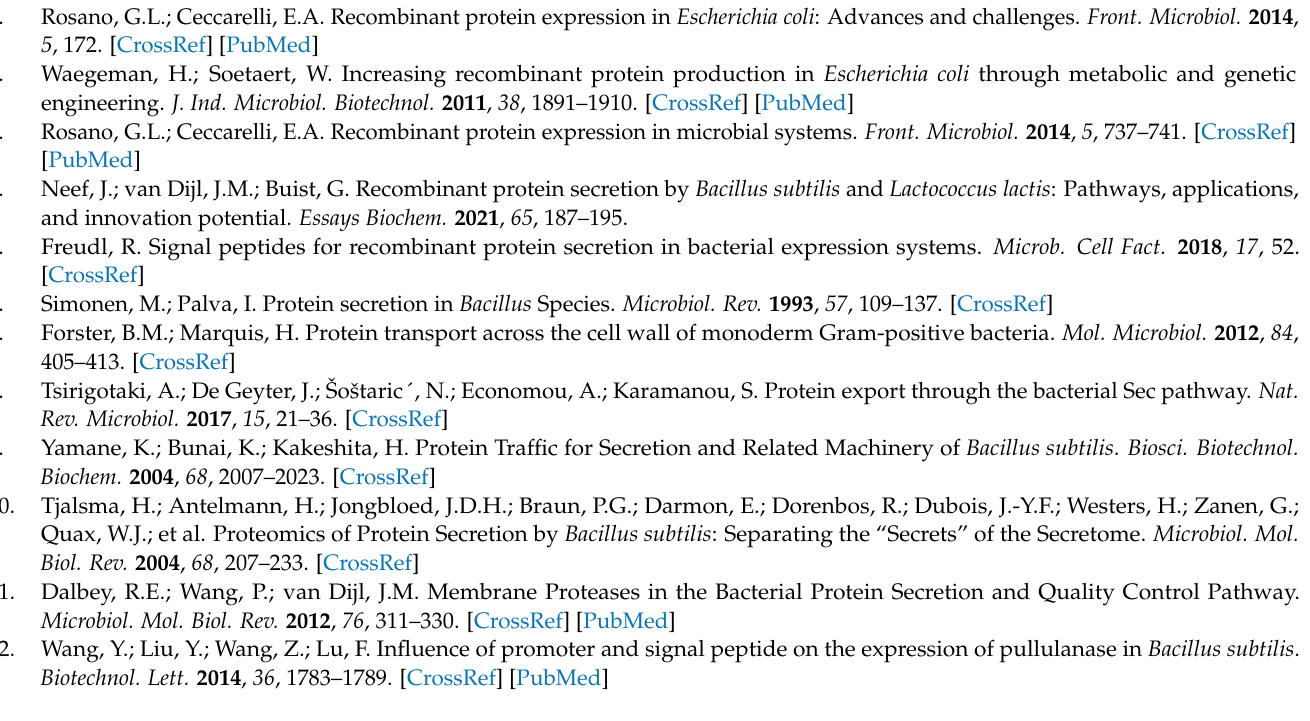
Table S2: List of primers, Table S3: List of signal peptides available at pMSP1, Table S4: List of signal peptides available at pMSP2, Table S5: List of signal peptides available at pMSP3, Table S6: List of signal peptides available at pMSP4, Table S7: List of signal peptides available at pMSP5, Table S8: List of signal peptides available at pMSP6, Table S9: List of signal peptides available at pMSP7, Table S10: List of signal peptides available at pMSP8, Table S11: List of signal peptides available at pMSP9, Table S12: List of signal peptides available at pMSP10, Figure S1: Compari- son of secreted amount of BmasPGA of selected clones in upscaling. Reference [50] is cited in the supplementary